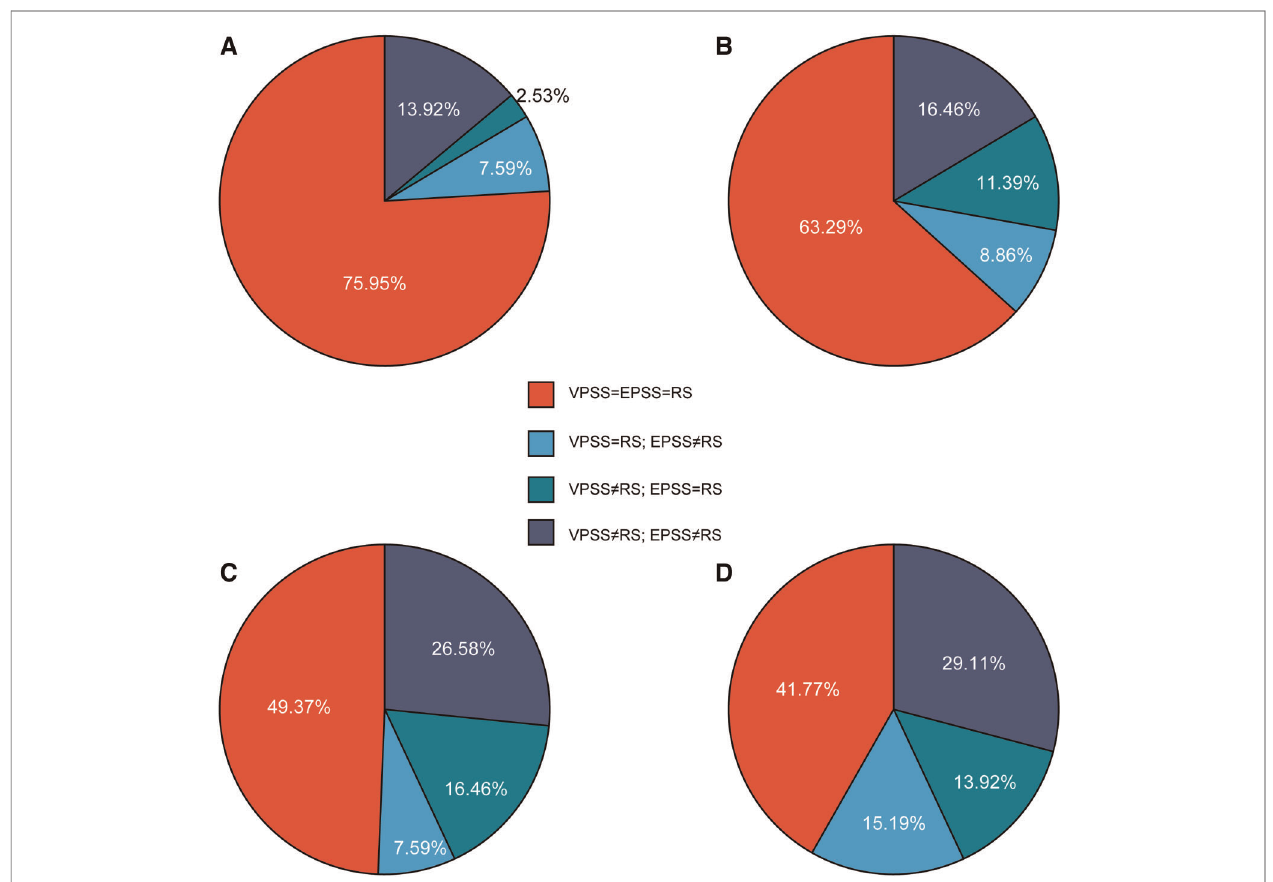
FIGURE 3 | Pie charts to analyze speci fi c accuracy. ( A ) – D ) represented questions 1 to 4. We compared the patients ’ answers in VPSS and EPSS with the reference score (RS) to see which scale captured more answers identical to RS while the other did not. In ( A ), both scales collected most of the answers identical to RS (75.95%), showing no prominent advantages. In ( A ) and ( B ), more than half of the answers collected on both scales were the same (75.95%% and 63.29%, respectively). However, panels ( C ) and ( D ) showed a sharp decrease (red part). Especially in ( C ), more identical answers were captured by EPSS independently (26.58%), indicating that EPSS shows advantages to VPSS in question 3. It proves the positive effect of animation. In ( D ), VPSS and EPSS showed approximate and poor speci fi c accuracy (15.19% and 19.92%, respectively), con fi rming the result of the Sankey diagram ( Figure 4 ).